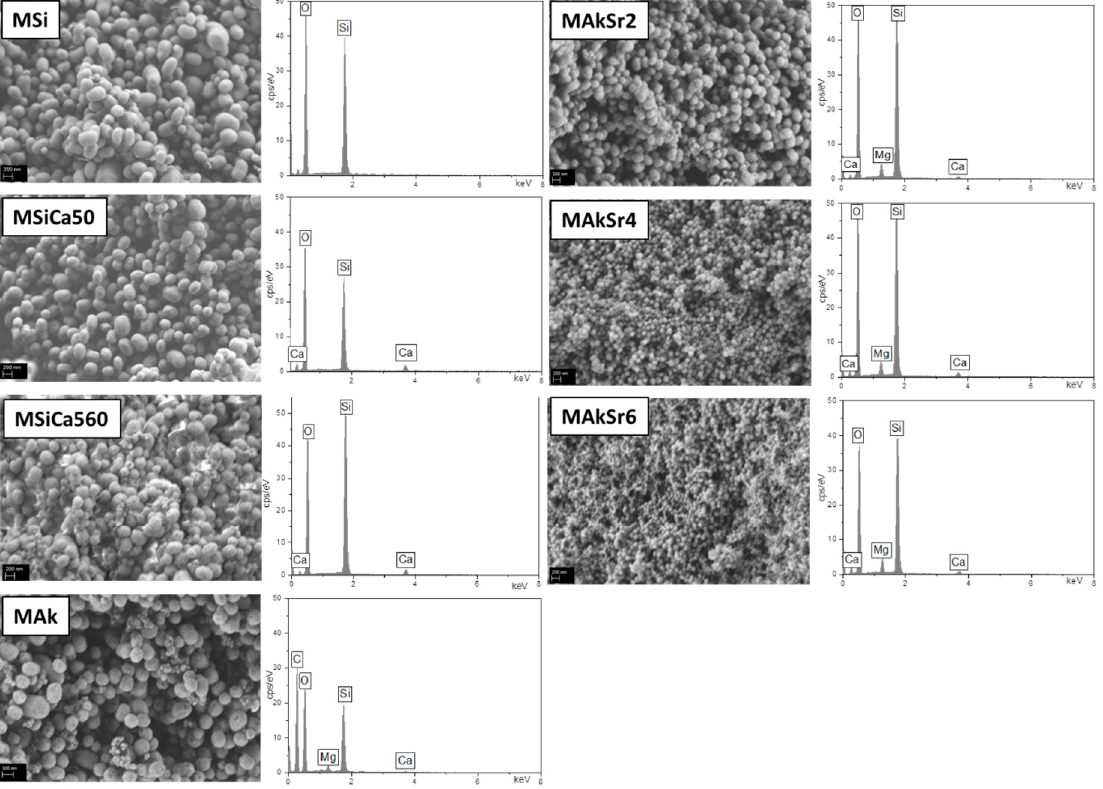
Figure 5. SEM micrographs (45.000× magnification, scale bar for MAk 300 nm, for the rest 200 nm) of the synthesized mesoporous silica-based nanoparticles (MSNs). The respective EDX spectra are incorporated.